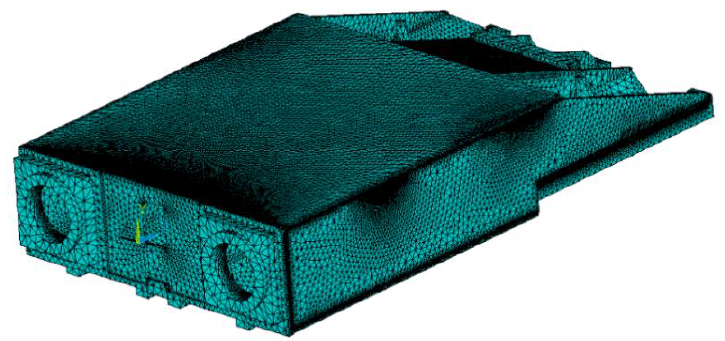
Figure 8. Finite-element model of the carriage.